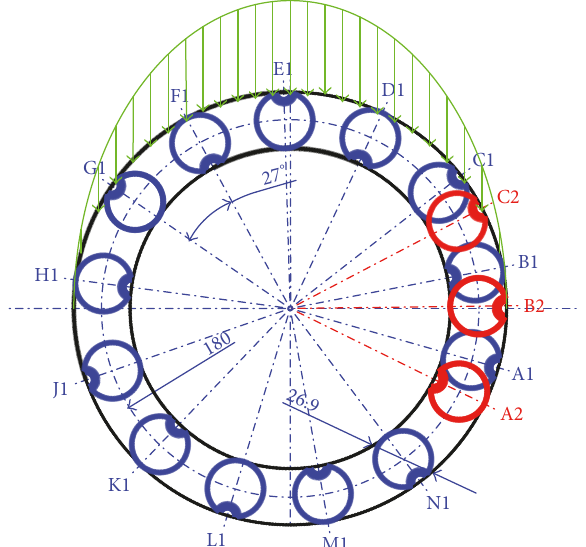
Figure 14: The relative motion between the rollers and races and the load zone